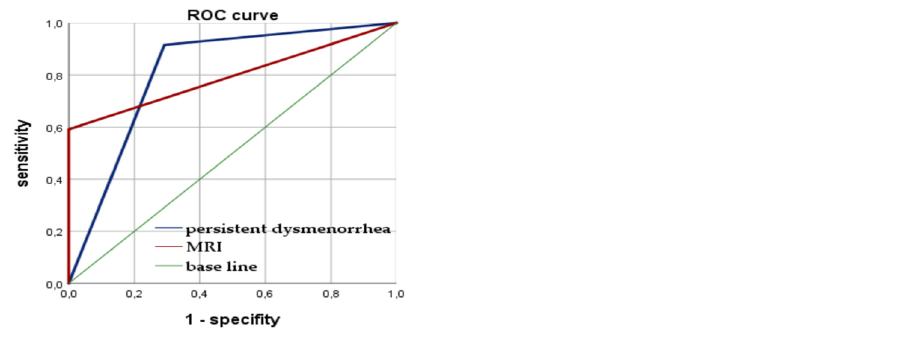
Figure 5. Diagnostic accuracy of MRI signs (ROC curve: area under the curve (AUC) = 0.796, p < 0.05) and persistent dysmenorrhea (AUC) = 0.812, p < 0.05) in predicting PE.